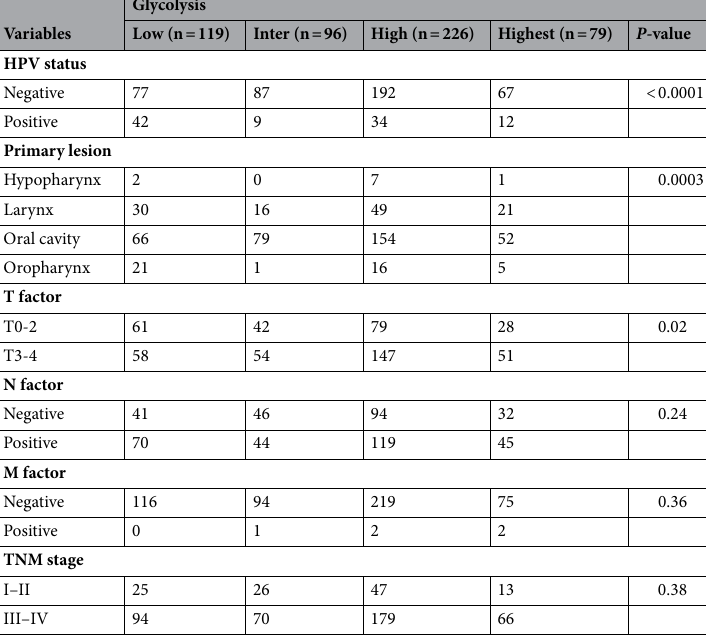
Table 1. Relationship between glycolytic activity and clinical parameters in 520 patients with HNSCC. HNSCC, head and neck squamous cell carcinoma; HPV, human papillomavirus; TNM, tumor-node- metastasis; inter,